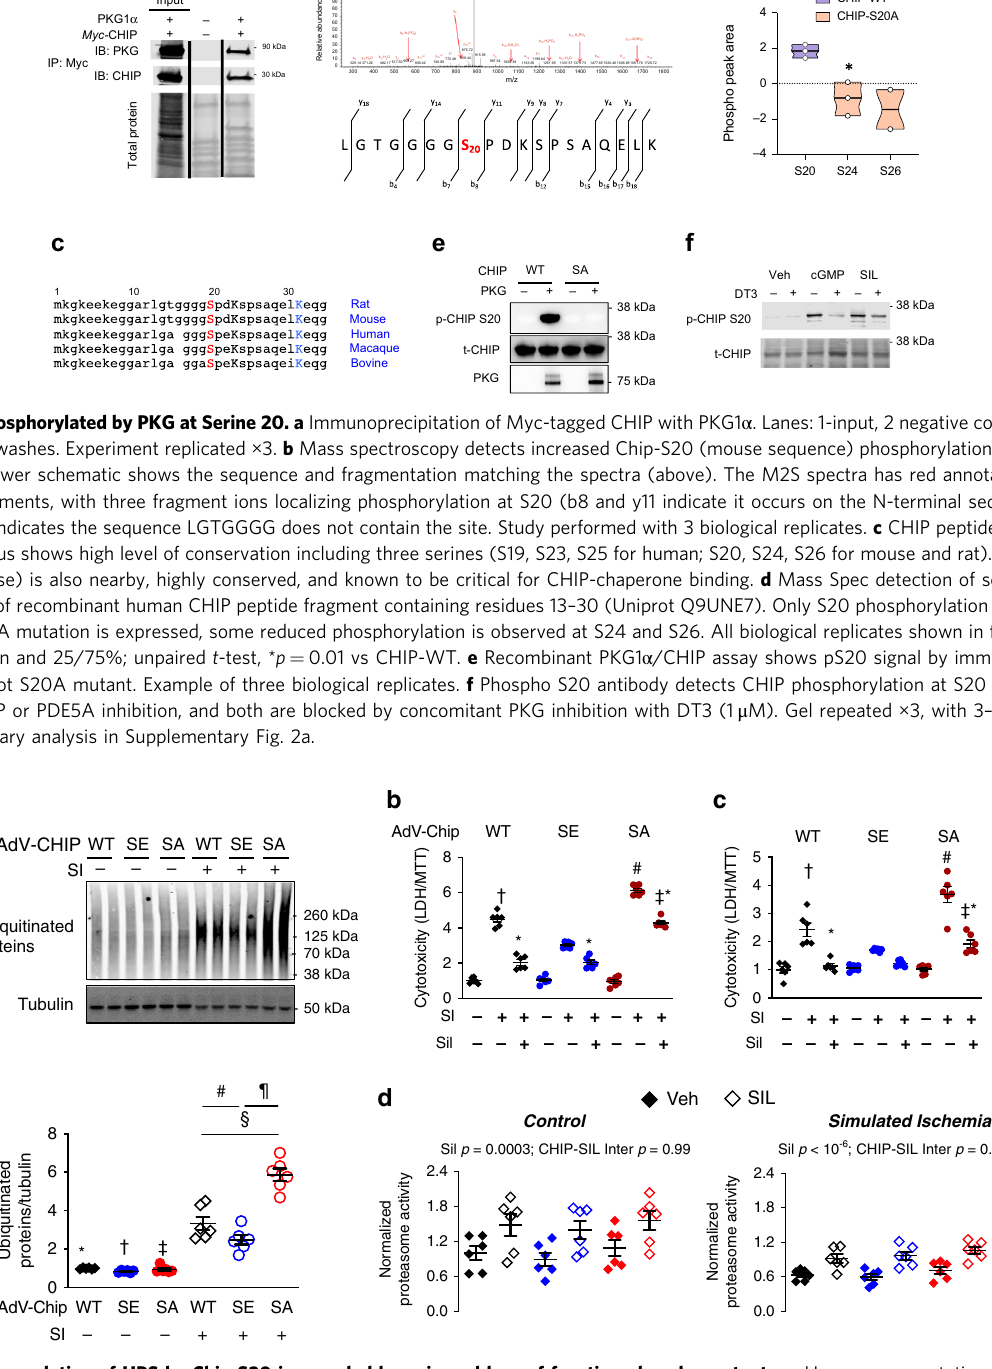
Fig. 3 Functional regulation of UPS by Chip S20 is revealed by gain and loss of function phospho-mutants. a Upper: representative Western blot of ubiquitinated proteins in NRCMs infected with adenovirus expressing WT, S20E (SE), or S20A (SA) CHIP, and exposed to normal or SI conditions for 48 h; Lower: summary results, data normalized for protein loading, and to control WT-CHIP; three gels, six biological replicates, 2WANOVA, Tukey mct: * p = 7 × 10 − 8 , † 3 × 10 − 5 , ‡ 10 − 9 , § 4 × 10 − 8 , ¶ <10 − 9 , # 0.03. b Cytotoxicity (LDH/MTT assays) from SI is reduced by (SE) and increased by SA CHIP expression versus WT. PDE5A inhibitor sildena fi l (SIL) reverses cytotoxicity in WT, but less so with SE or SA expression. 2WANOVA, 1.3 × 10 − 5 genotype condition interaction; Sidak mct: † p = 1.3 × 10 − 8 vs SE-SI, 1.2 × 10 − 9 vs SA-SI; # 10 − 11 SE-SI; ‡ <10 − 11 vs WT-SI + SIL and SE-SI + SIL; * p < 2 × 10 − 5 vs SI for each respective CHIP group. c Same experiment using AdV expressing combined (S20E, S24E; SE) or (S20A, S24A; SA). 2WANOVA, Sidak mct: † p = 0.01vs SE-SI, 2 × 10 − 5 vs SA-SI; # 4.8 × 10 − 9 SE-SI; ‡ 0.03 vs SE-SI + SIL; p = 0.005 vs WT-SI + SIL; *1.4 × 10 − 5 vs WT-SI, 5.6 × 10 − 8 , vs SA-SI. d Proteasome activity in resting NRCMs is augmented by PKG activation by PDE5 inhibitor sildena fi l (SIL) in control myocytes and cells subjected to SI. Results of 2W- ANOVA for SIL effect and for interaction between SIL effect and gene-type of CHIP expressed are provided in the fi gures. N = 6 biological replicates for all conditions/groups. Source data are provided as a Source Data fi le. Individual data and mean ± SEM shown in each summary